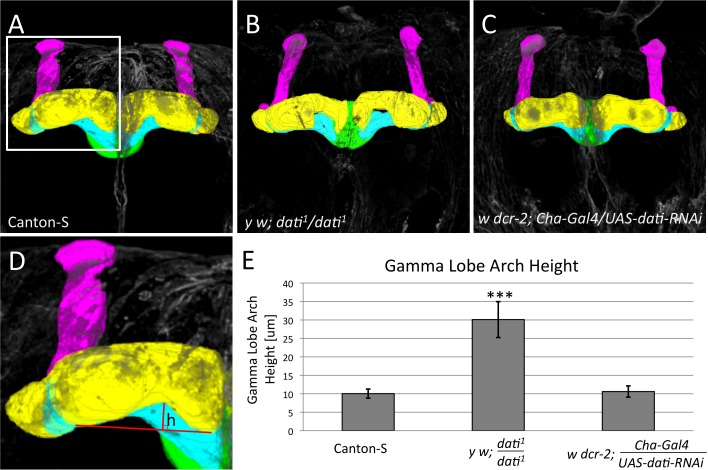

dati
1 homozygote females exhibit mushroom body defects, whereas Cha-Gal4/UAS-dati-RNAi females do not.(A–D) 3D segmentations of mushroom bodies visualized by anti-FasII staining of (A) wild type, (B) dati1 homozygous, and (C) Cha-Gal4/UAS-dati-RNAi females. The α lobe (magenta), β lobe (blue), γ lobe (yellow), and ellipsoid body (green) are indicated. Note that the γ lobes in (B) are more curved than the gamma lobes in (A) and (C). Note that the genotype in (C) causes rejection like dati1 homozygous females (B), but not locomotor defects (Figure 1G). (D) Mushroom body shown in (A, box) and measurement of the morphological defect of the γ lobe. Red lines show the base (horizontal) and height (vertical) of the mushroom body arch. (E) Graph shows that there is a significant increase in the height (h) of the mushroom body arch in comparison to wild-type and Cha-Gal4<UAS-dati-RNAi females. All images are 3D reconstructions of confocal stacks rendered in Fiji. Error bars are ±standard deviation. Significance was tested by a two-sample t test and *** indicates p<0.001. The 3D reconstructions of the mushroom bodies are shown in Movie S4. Sample sizes are: Canton-S (N = 12), dati
1 (N = 12), and Cha-Gal4>UAS-dati-RNAi (N = 14).